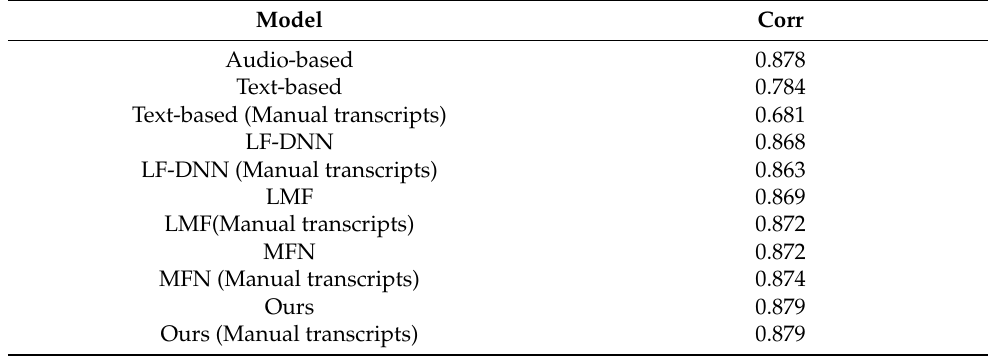
Table 10. The performance on the PSCPSF